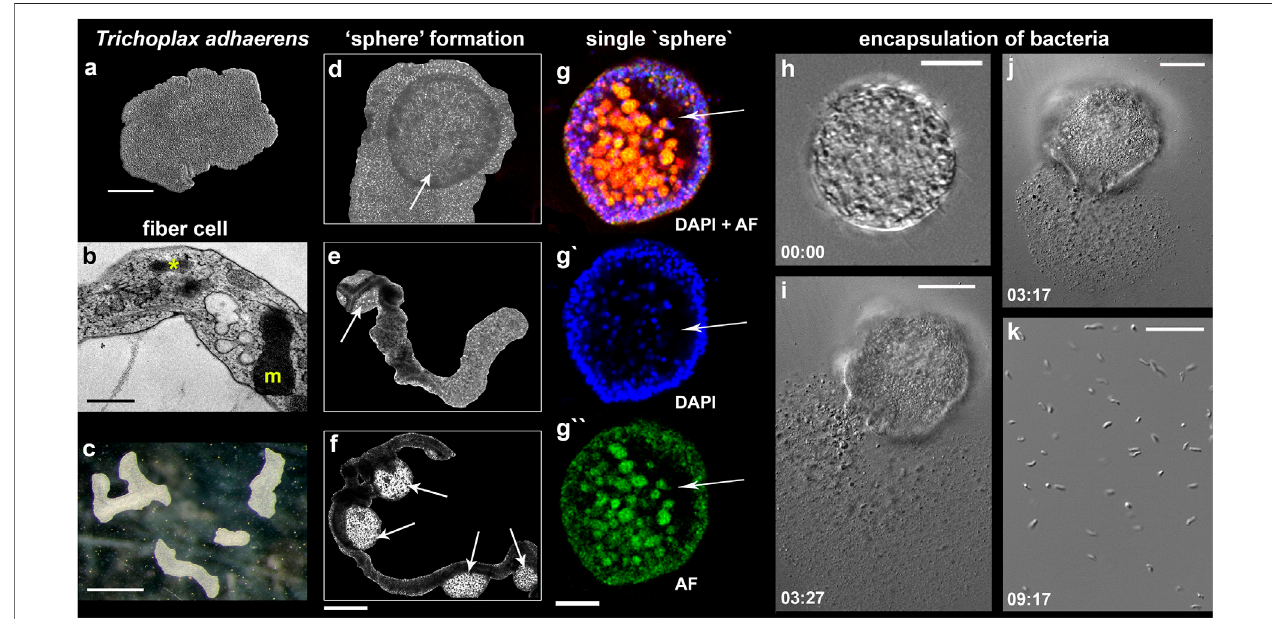
FIGURE 7 | “ Sphere ” -type formations in Trichoplax adhaerens . (A – C) control animals under optimal culture conditions (mode #1, see text and Figure 3 ); (B) — Transmission electron microscopy (TEM) image of the fi ber cell with a bacterium (asterisk) and a large mitochondrial complex (m). (D – H) – Formation of spheres (arrows) from the upper/dorsal epithelium. (D) — disk-like animal; (E,F) -animals with elongated bodies; (E) — one “ sphere ” (arrow); (D) — four “ spheres ” (arrows). ( G – G @ ) — Separated spheres with internal cavities (arrows); Nuclear DAPI staining — blue [excited by the violet (~405 nm) laser with blue/cyan fi lter (~460 – 470 nm)]; Auto fl uorescence (AF) — green (excitation 490 nm and emission 516 nm). (I – K) — Spherical formations encapsulate bacteria inside; (I – J) — the damage of the sphere ’ s surfacebylaserreleasednumerousbacteria(magni fi edin (K) ;seetextfordetails).Timeintervalsfollowingthelaser-inducedinjuryareindicatedintheleftcornersofeach image. Scale: a 200 μ m, (B) — 500 nm, (C) — 1 mm, ( G – G @ ) — 400 μ m, (G – I) — 20 μ m, (K) — 10